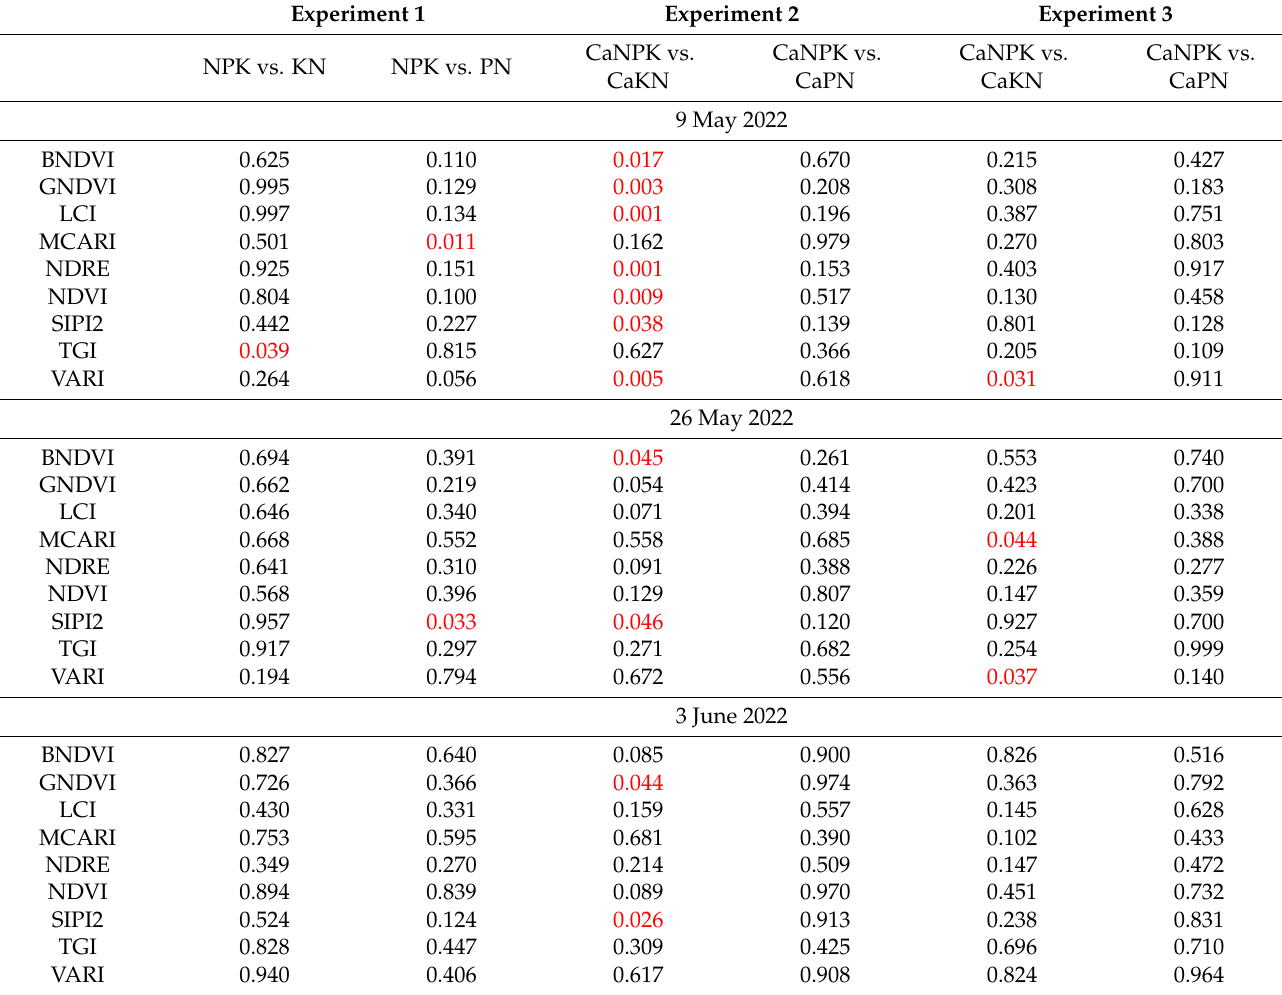
Table 7. p -values based on the t -test for comparisons of vegetation indices between treatments with complete fertilization (NPK) and with deficiency of phosphorus (KN) or potassium (PN). p -values which indicate significant differences are marked in red. Experiment 1 Experiment 2 Experiment 3 CaNPK vs. NPK vs. KN NPK vs. PN